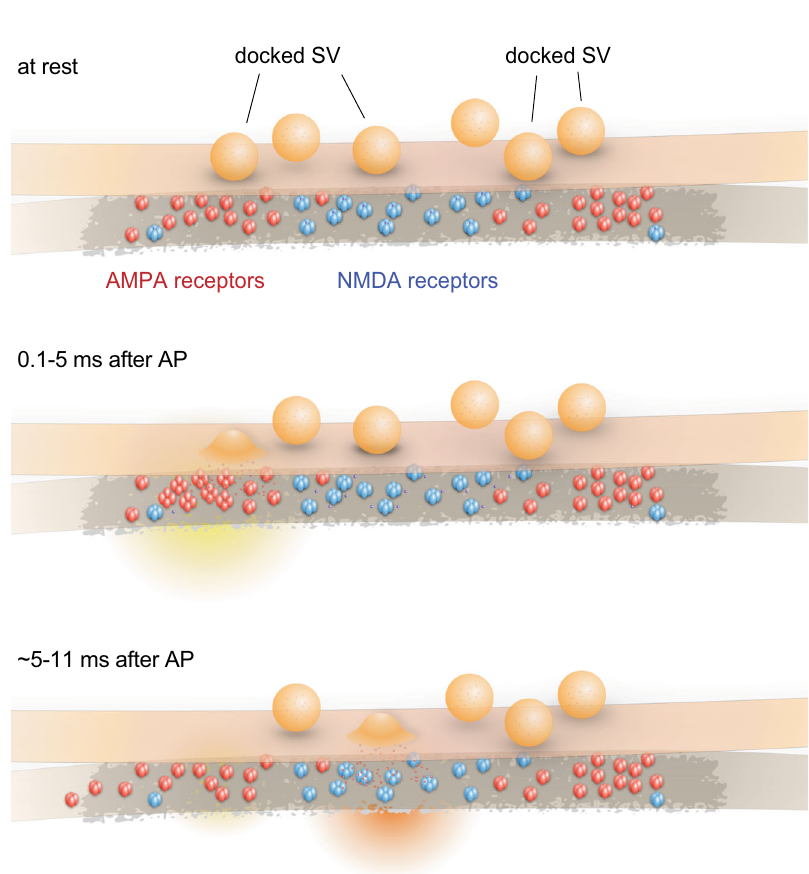
Fig. 5 Proposed synaptic organization and events. a Schematic of proposed synaptic organization and events. Docked vesicles are found throughout the active zone. AMPA receptors are found toward the edge, while NMDA receptors are biased toward the center. Synchronous fusion begins within hundreds of microseconds near the AMPA receptor cluster. Released glutamate activates AMPA receptors, which, in turn, depolarizes the membrane and alleviates the Mg 2 + block of NMDA receptors. Between 5 and 11 ms, residual calcium triggers asynchronous fusion, preferentially toward the center of the active zone and across from the NMDA receptor cluster, favoring the NMDA receptors. Although shown here as taking place in the same active zone, the degree to which synchronous and asynchronous release may occur at the same active zone after a single action potential is unknown. This transsynaptic organization allows the maximal depolarization of the postsynaptic membrane and ef fi cient activation of NMDA